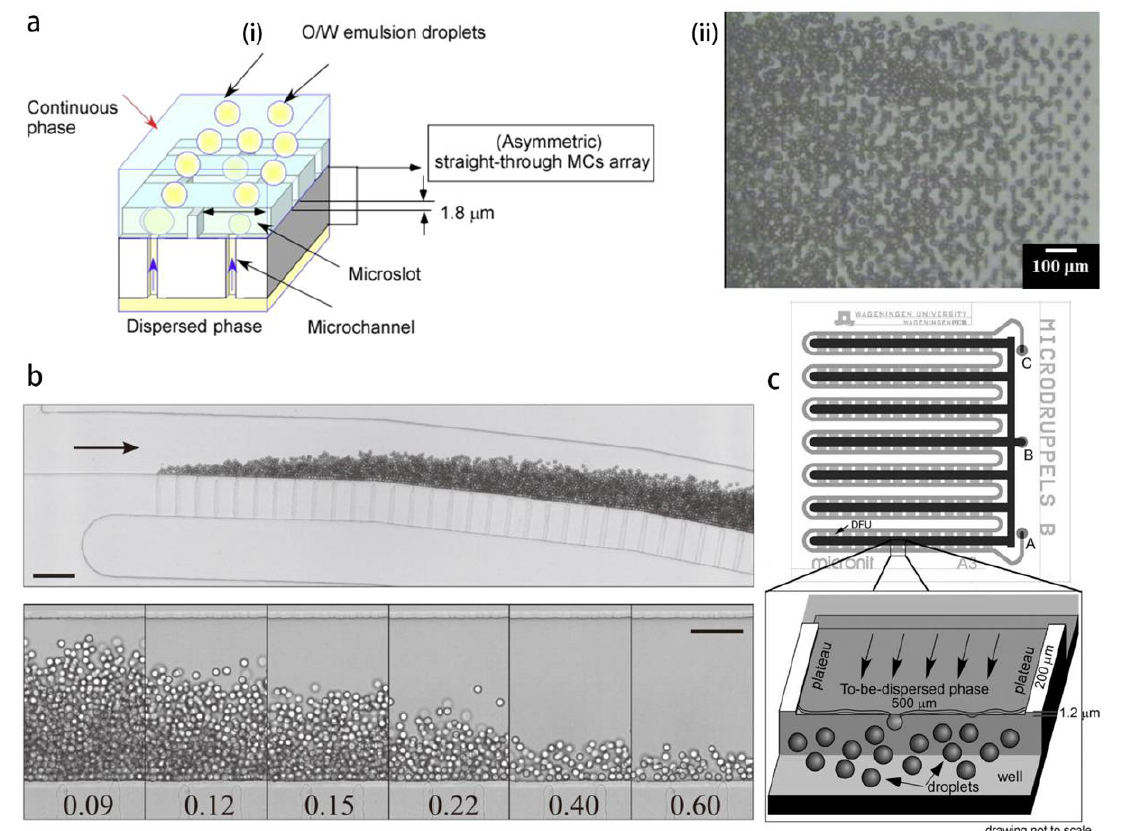
Figure 8. Principal step-emulsification strategies for enhancing droplet production rate. ( a ) Mem- brane with asymmetric straight-through microchannels ( i ) and a whole view of droplet generation ( ii ). Reproduced from [88], copyright 2017, WILEY-VCH Verlag GmbH & Co. KGaA, Weinheim. ( b ) Emulsification via parallelized channels to form microdroplets. Reproduced from [77], copyright 2014, AIP. ( c ) Edge-based droplet generator composed of a number of ultra-shallow channels, that each of them forms microdroplets along different spanwise positions. Reproduced from [92], copyright 2010, Elsevier.